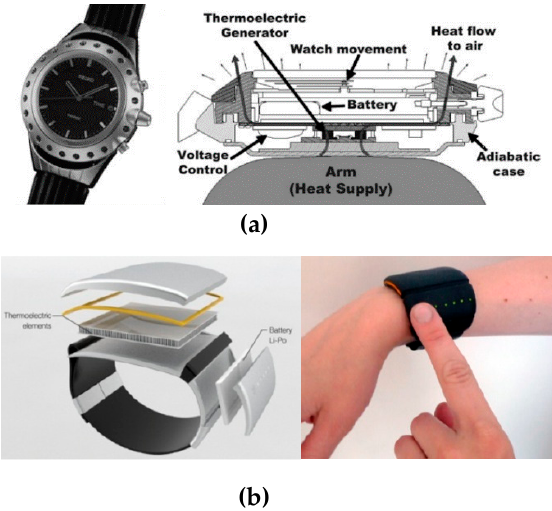
Figure 12. ( a ) Seiko Thermic, wristwatch [137]; ( b ) Dyson bracelet [138].